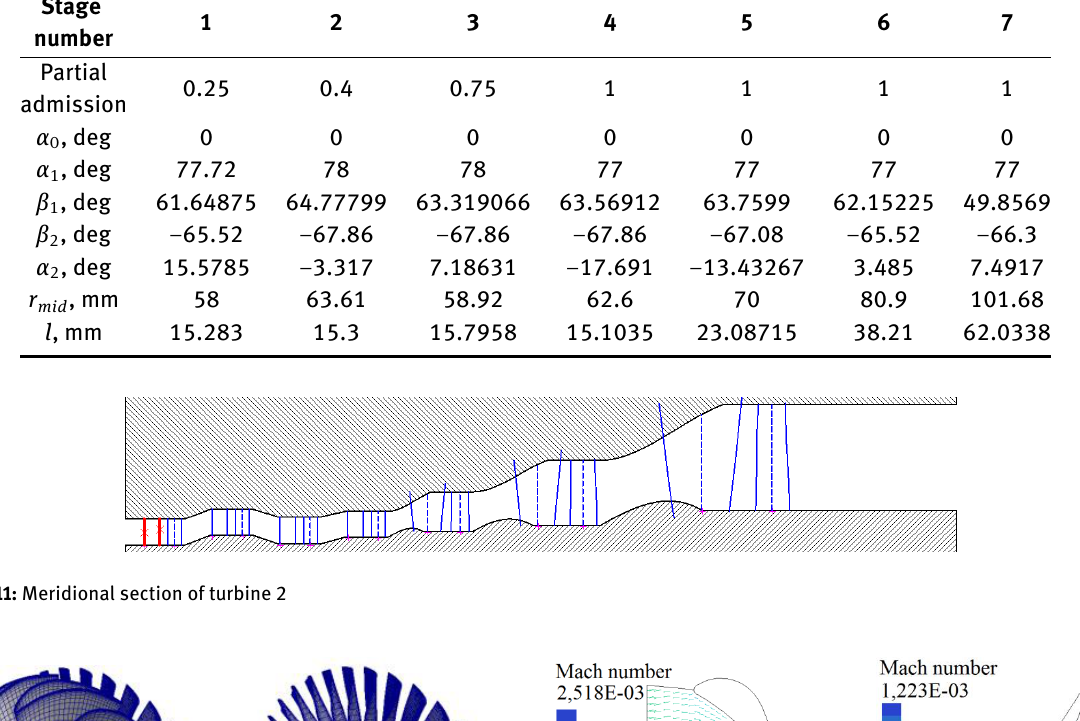
Figure 14. Velocity vectors colored by Mach number in a blade-to-blade section at the mid-span of stage 7 A view and basic geometric characteristics of an alternative radial-axial turbine flow